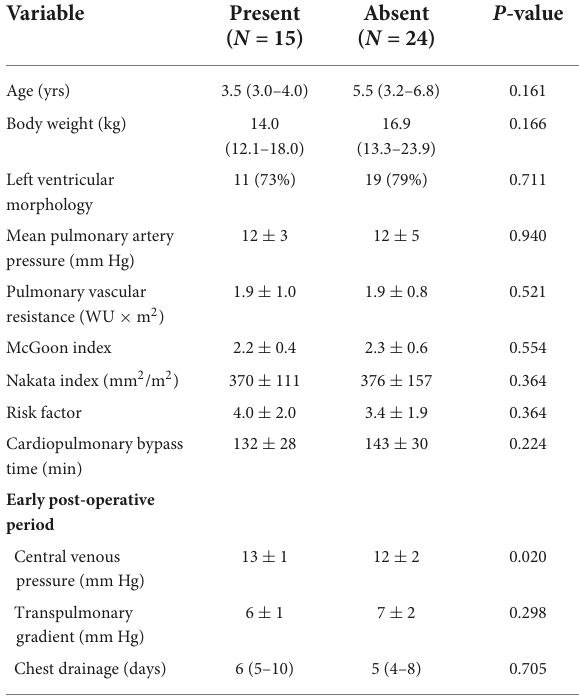
Dataarerepresentedasmean ± SDormedian(IQR)asappropriate.